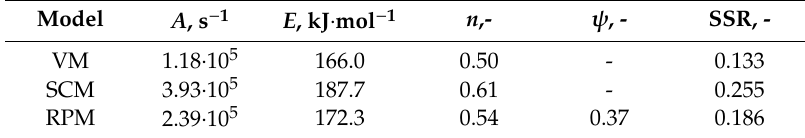
Table 3. Optimal values of the kinetic parameters of RPC char samples for di ff erent models.